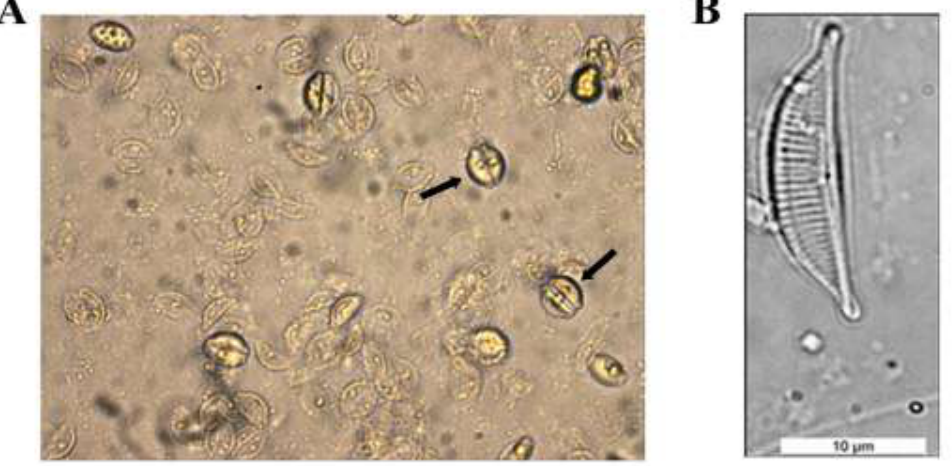
Figure 3. Photographs of a culture of Amphora coffeaeformis grown and maintained at the Laboratory of Genetics, University of Camerino (Camerino, Italy); live diatom species observed under an inverted microscope at 400× magnification are shown on panel ( A ), while the characteristic frustule of oxidized Amphora coffeaeformis cells, observed at 1000× magnification, is shown on panel ( B ); the arrows in panel ( A ) indicate cells undergoing cell